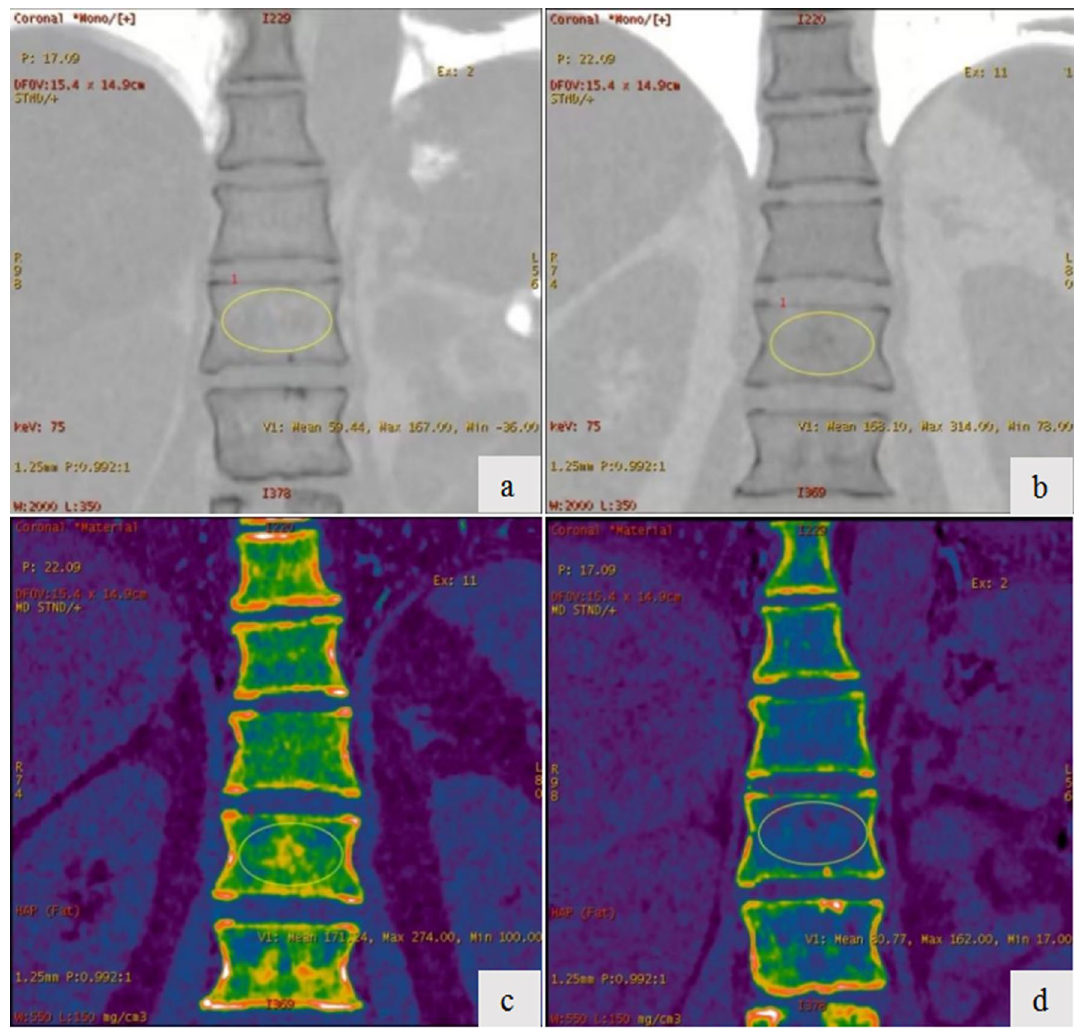
Figure 3. The coronal-view CT image and HAP image of thoracolumbar spine. The ROI was drawn on the 1st lumbar. CT value: ( a ), Non-Osteoporosis group; ( b ), osteoporosis group; HAP concentration: ( c ), Non- Osteoporosis group; ( d ), osteoporosis